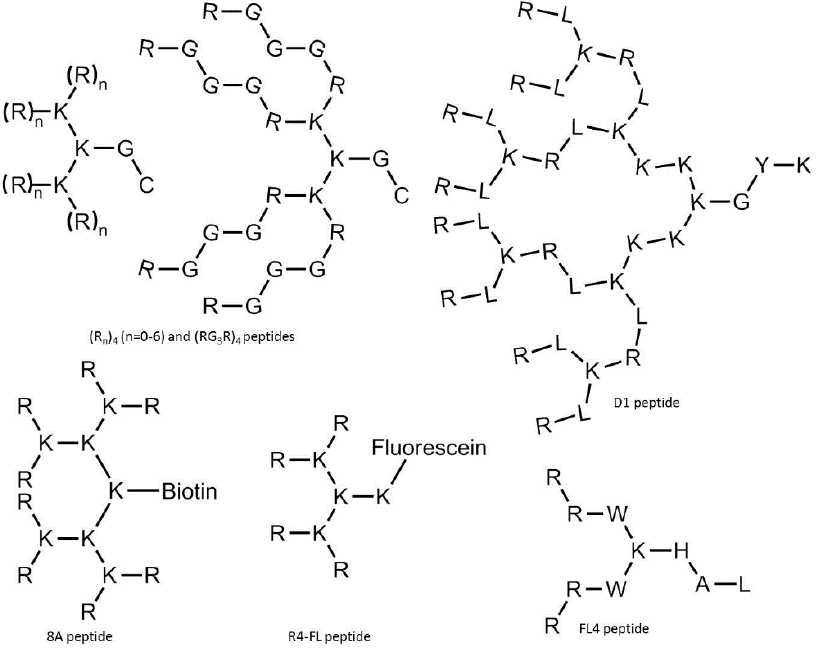
Figure 5. Examples of branched-type CCPs.